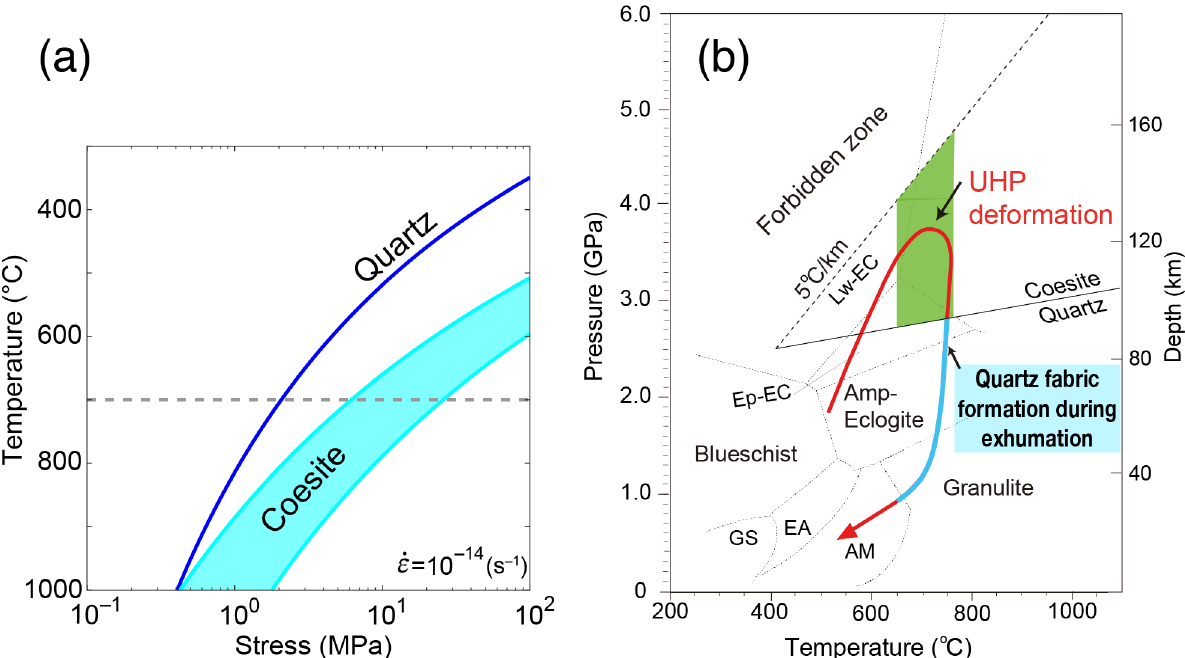
Figure 8. ( a ) Flow strength comparison between quartz and coesite at a natural strain rate of 10 − 14 s − 1 . Flow law parameters for quartz: A = 5.1 × 10 − 4 MPa − 4 s − 1 , n = 4, Q = 223 kJ/mol. Flow law parameters for coesite: ln A = − 8.0 to − 3.7 MPa − 3 s − 1 , n = 3, Q = 275 kJ/mol. Mean values are used, with parameters for quartz (~0.15 wt.% H 2 O) taken from Gleason and Tullis [68] calibrated by Holyoke and Kronenberg [69], and for coesite (~500 to 1000 × 10 − 6 H/Si) from Renner et al. [70]. For coesite, the error range of the preexponential factor ( A ) is large. The dashed line at a temperature of 700 ◦ C shows the estimated peak temperature for the Dabie coesite-bearing eclogite [5]. ( b ) Simplified P–T–deformation path for the Dabie UHP belt. In mafic–ultramafic rocks, deformation microstructures that were formed under UHP conditions have been preserved during exhumation. In felsic rocks, coesite transitioned to quartz during exhumation. Quartz fabrics in felsic rocks were formed during exhumation under quartz-stable pressure conditions. P–T path is from Carswell and Zhang [71] modified after Zhang et al. [5]. P–T boundaries represent metamorphic facies: GS, greenschist; EA, epidote-amphibolite; AM, amphibolite; Amp-Eclogite, amphibole-eclogite; Ep-EC, epidote-eclogite; Lw-EC,